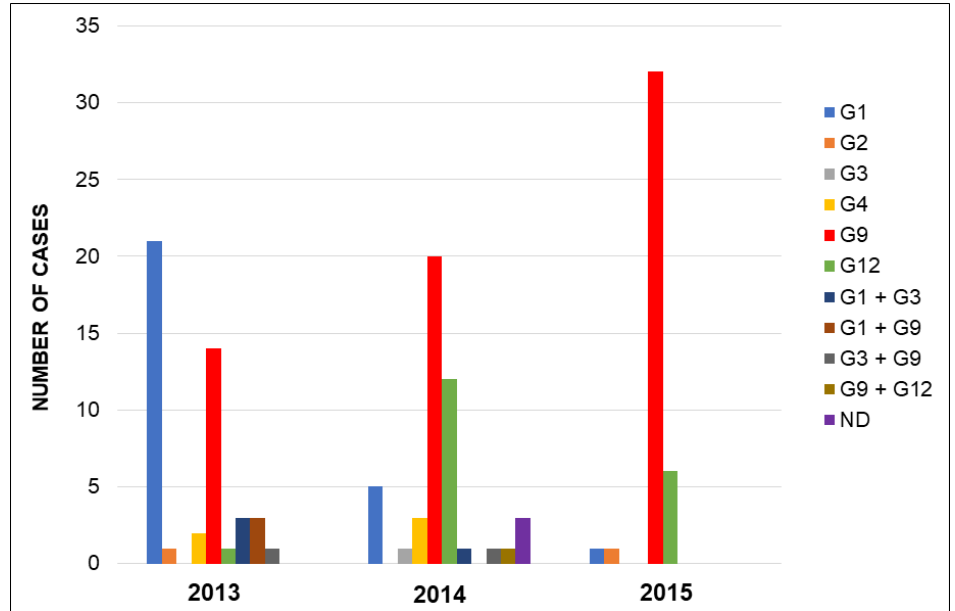
Figure 1. Temporal distribution of rotavirus G genotypes during the three-year study period. Regarding P genotypes, 98% of the strains were P[8] genotype with an overall dominance of G9P[8]. Abbreviations: ND, not determined.